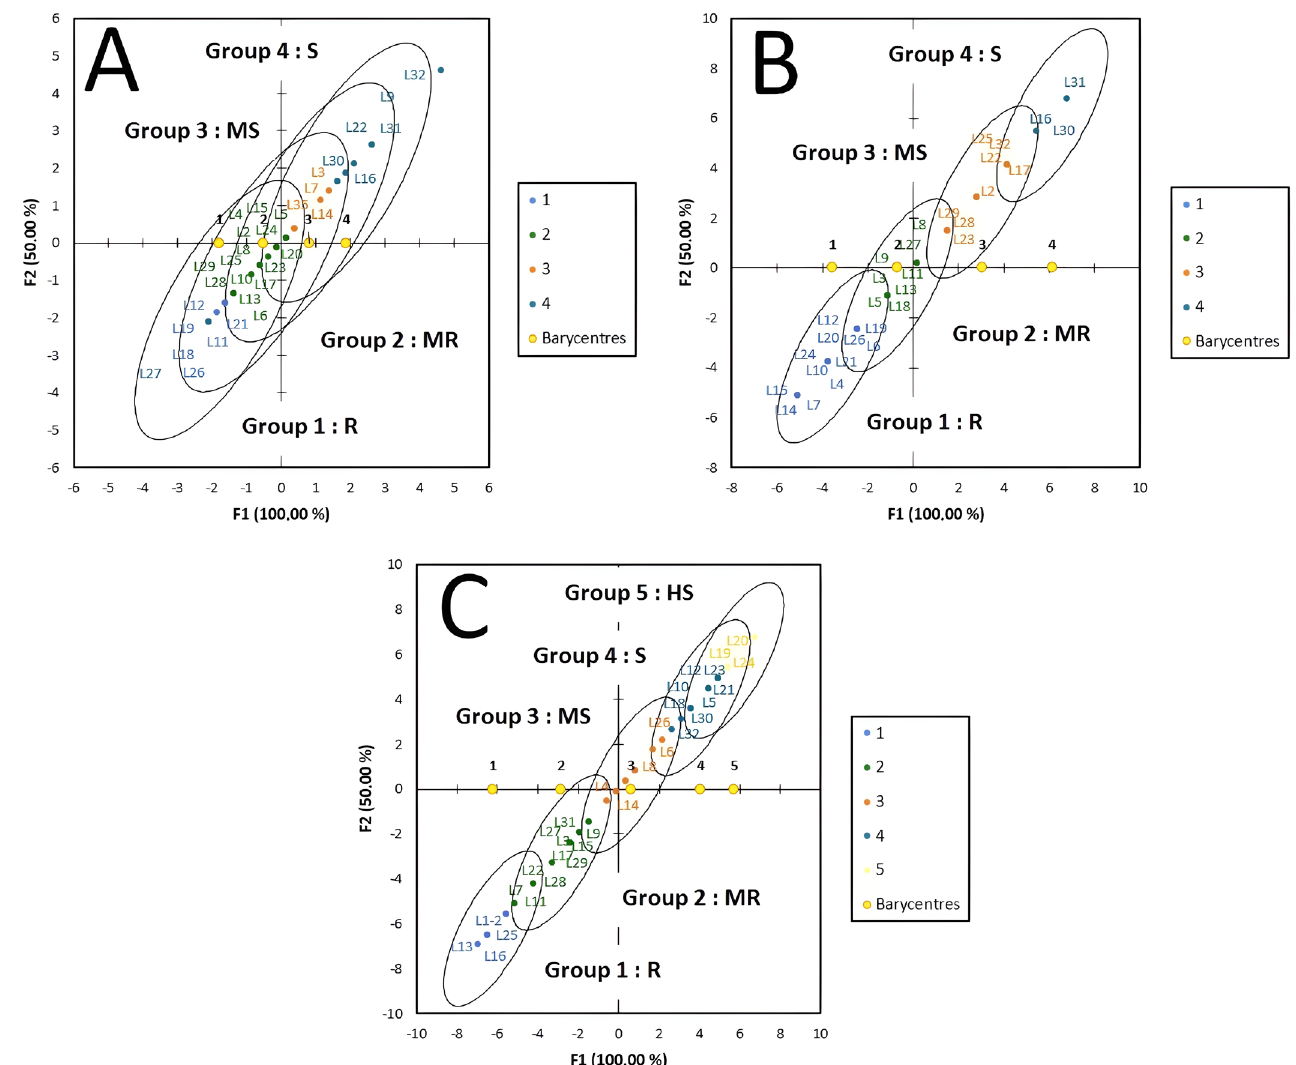
Figure 2. Discriminant factorial analysis (AFD) showing the population structure for a set of 32 lines from CIMMYT’s spring wheat nursery based on their resistance reaction against Fusarium culmorum . ( A ) Field conditions of three locations (Eskişehir, Yozgat, and Konya). ( B ) Greenhouse conditions in Eskişehir. ( C ) Growth room conditions in Eskişehir. Numbers represent resistance reaction: 1: resistant; 2: moderately resistant; 3: moderately susceptible; 4: susceptible; 5: highly susceptible. Yellow points represent the barycenter’s defining groups.